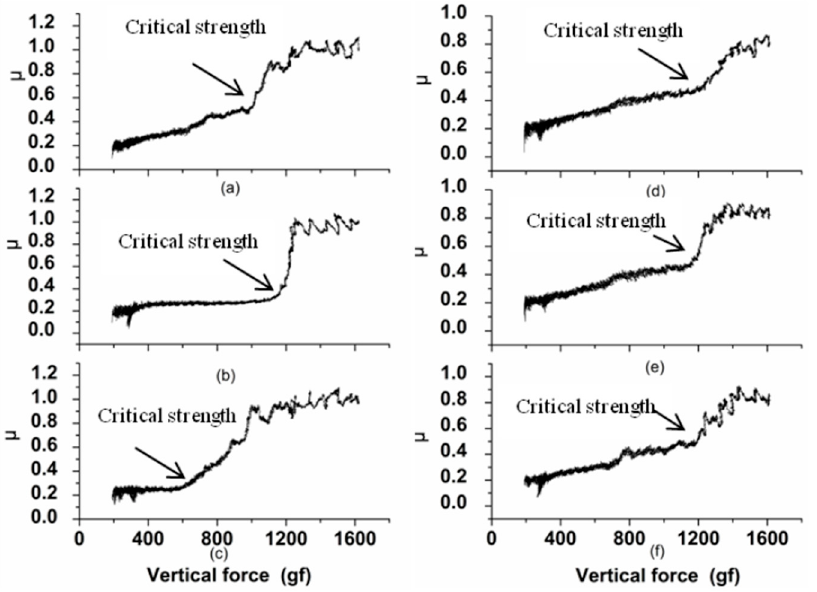
Figure 11. The friction coefficient curve: ( a ) 200 W; ( b ) 100 W; ( c ) 0 W; ( d ) 200 kHz; ( e ) 120 kHz; ( f ) 80 kHz.